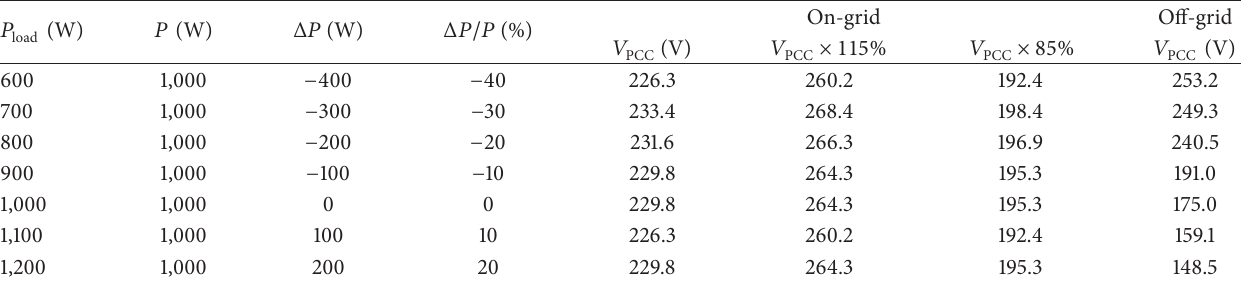
Table 4: Relationship between voltage and active power of